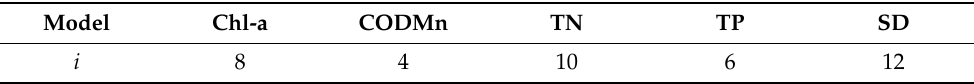
Table 3. The optimal number nodes in the hidden layer of the BP inversion model.